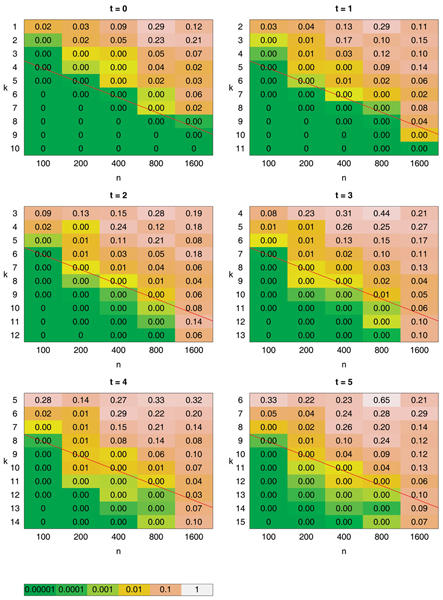
Kolmogorov-Smirnov p values for non-uniform compared with normal. (adapted from [13]) The letter distribution is fA = fT=, fG = fC = , and the diagonal red line in each table is k = 2n + const.